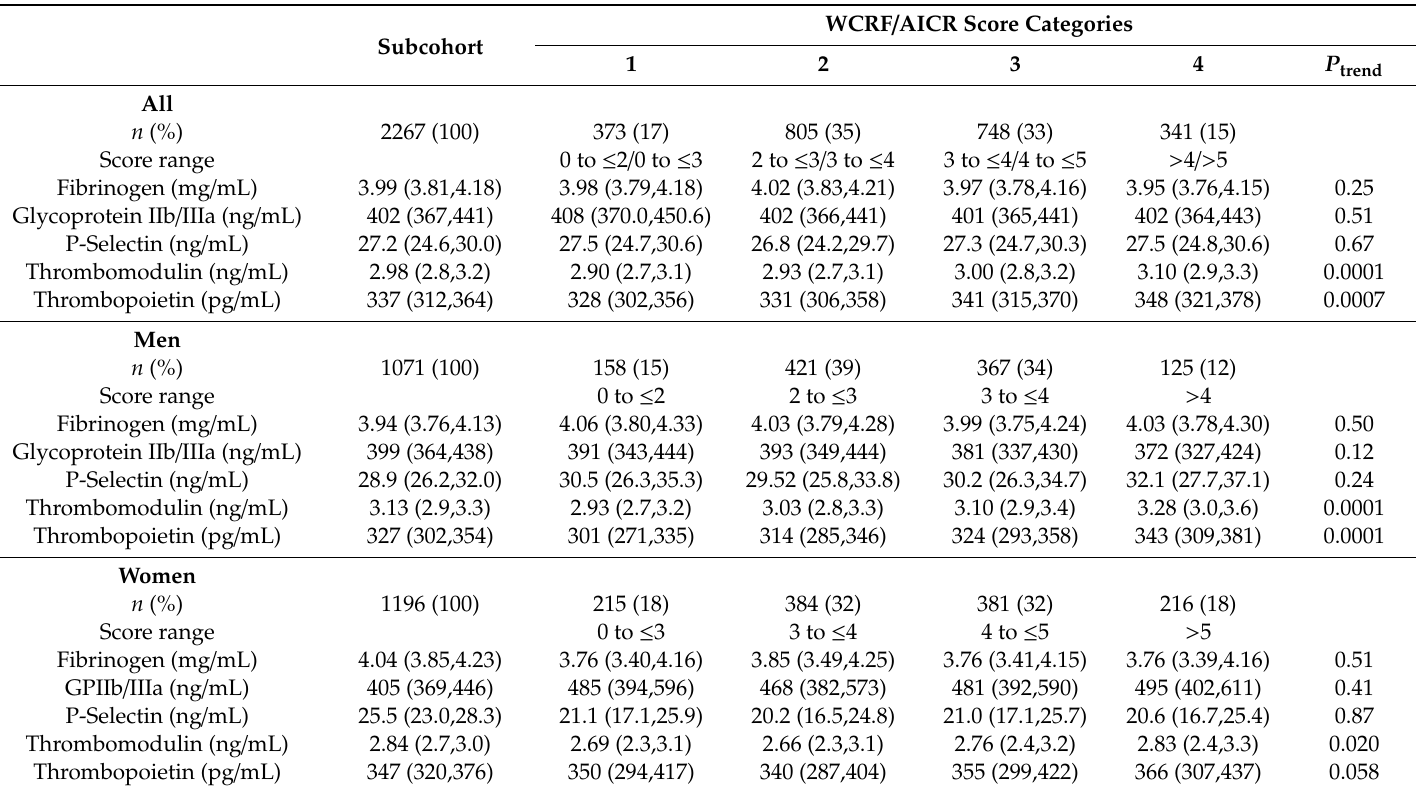
Table 3. Geometric means (95% confidence intervals) of biomarker levels across WCRF / AICR categories within the EPIC-Heidelberg subcohort by